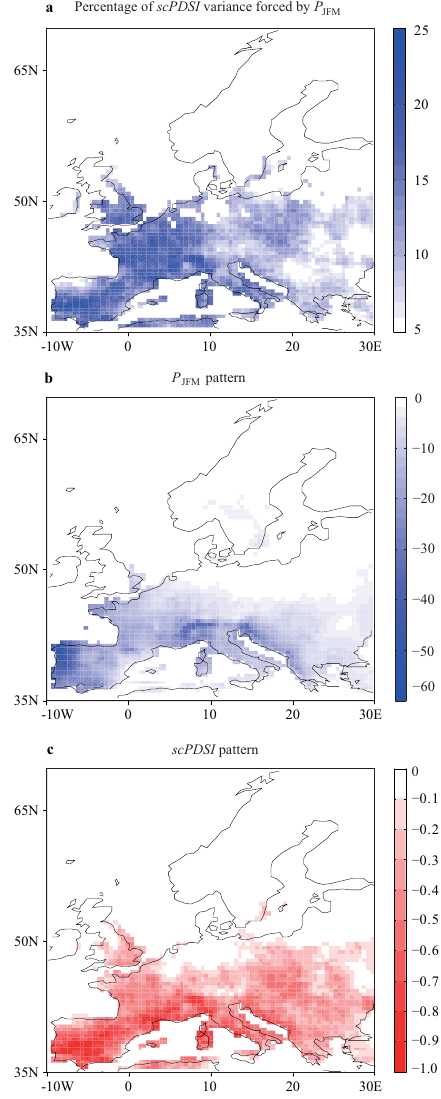
Fig. 2. The scPDSI variability forced by P JFM . (a) Percentage of scPDSI variance forced by P JFM (sig=0.01). The spatial patterns of (b) P JFM and (c) its scPDSI response for the 1st MCA mode. The MCA time coefficient series have unit correlation, shown in Fig.